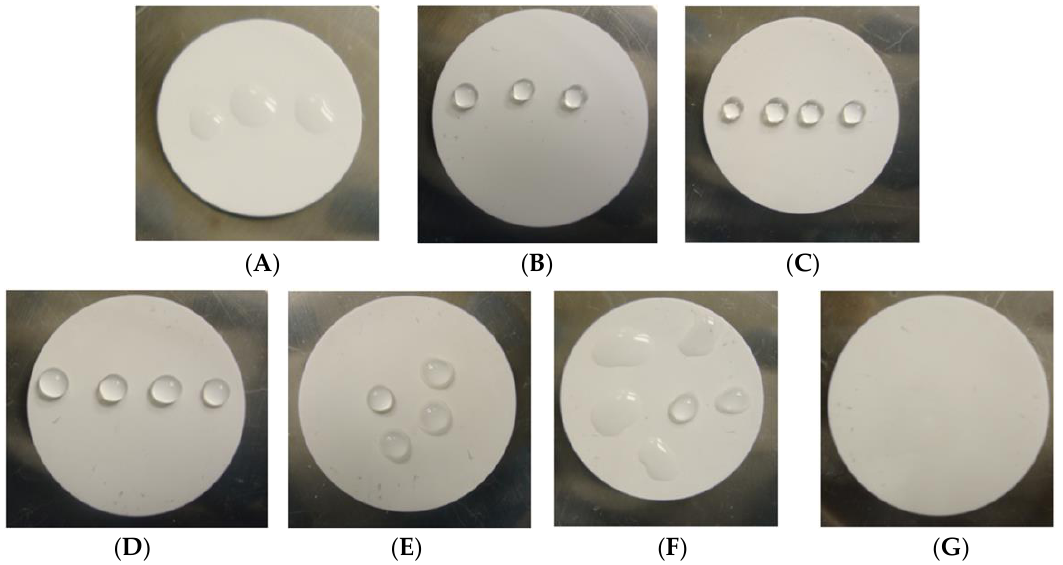
Figure 7. Surface hydrophobicity test to monitor the stability of wetting properties of a superhydrophobic membrane surface. ( A ) Blank alumina disc surface (hydrophilic in nature); ( B ) After PDTMS functionalization, showing superhydrophobicity (172° contact angle); ( C ) After PDTMS modification and heated at 300 °C for 2 h (still showing 172° contact angle); ( D ) After 300 °C for additional 4 h (172°); ( E ) After 350 °C for 2 h (136°); ( F ) 350 °C for additional 4 h (surface is wettable now with water droplets); and ( G ) 400 °C for 2 h (surface becomes so hydrophilic, and water droplets can penetrate into the disc surface and disappear).